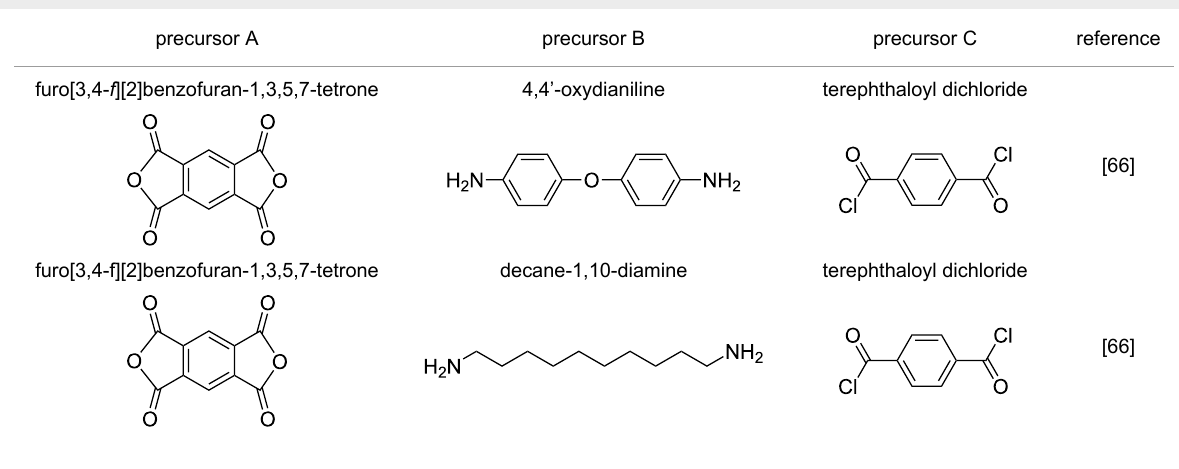
Table 5: Precursors used to deposit polyimide–amide thin films. precursor